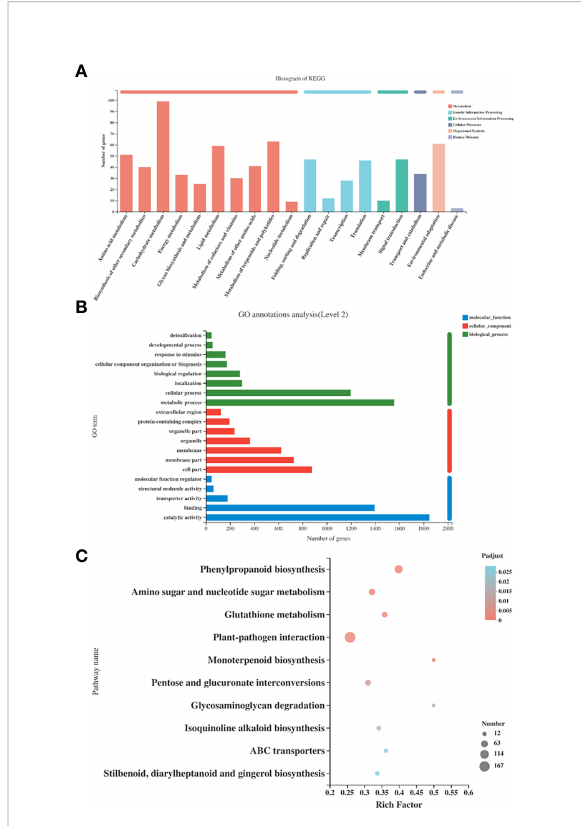
FIGURE 6 Functional GO and Kyoto Encyclopedia of Genes and Genomes (KEGG) pathway classi fi cation of differentially expressed genes. (A) KEGG annotation histogram of differentially expressed genes. (B) GO annotation histogram of differentially expressed genes. (C) Top 20 KEGG pathways with the most signi fi cant enrichment in the 2